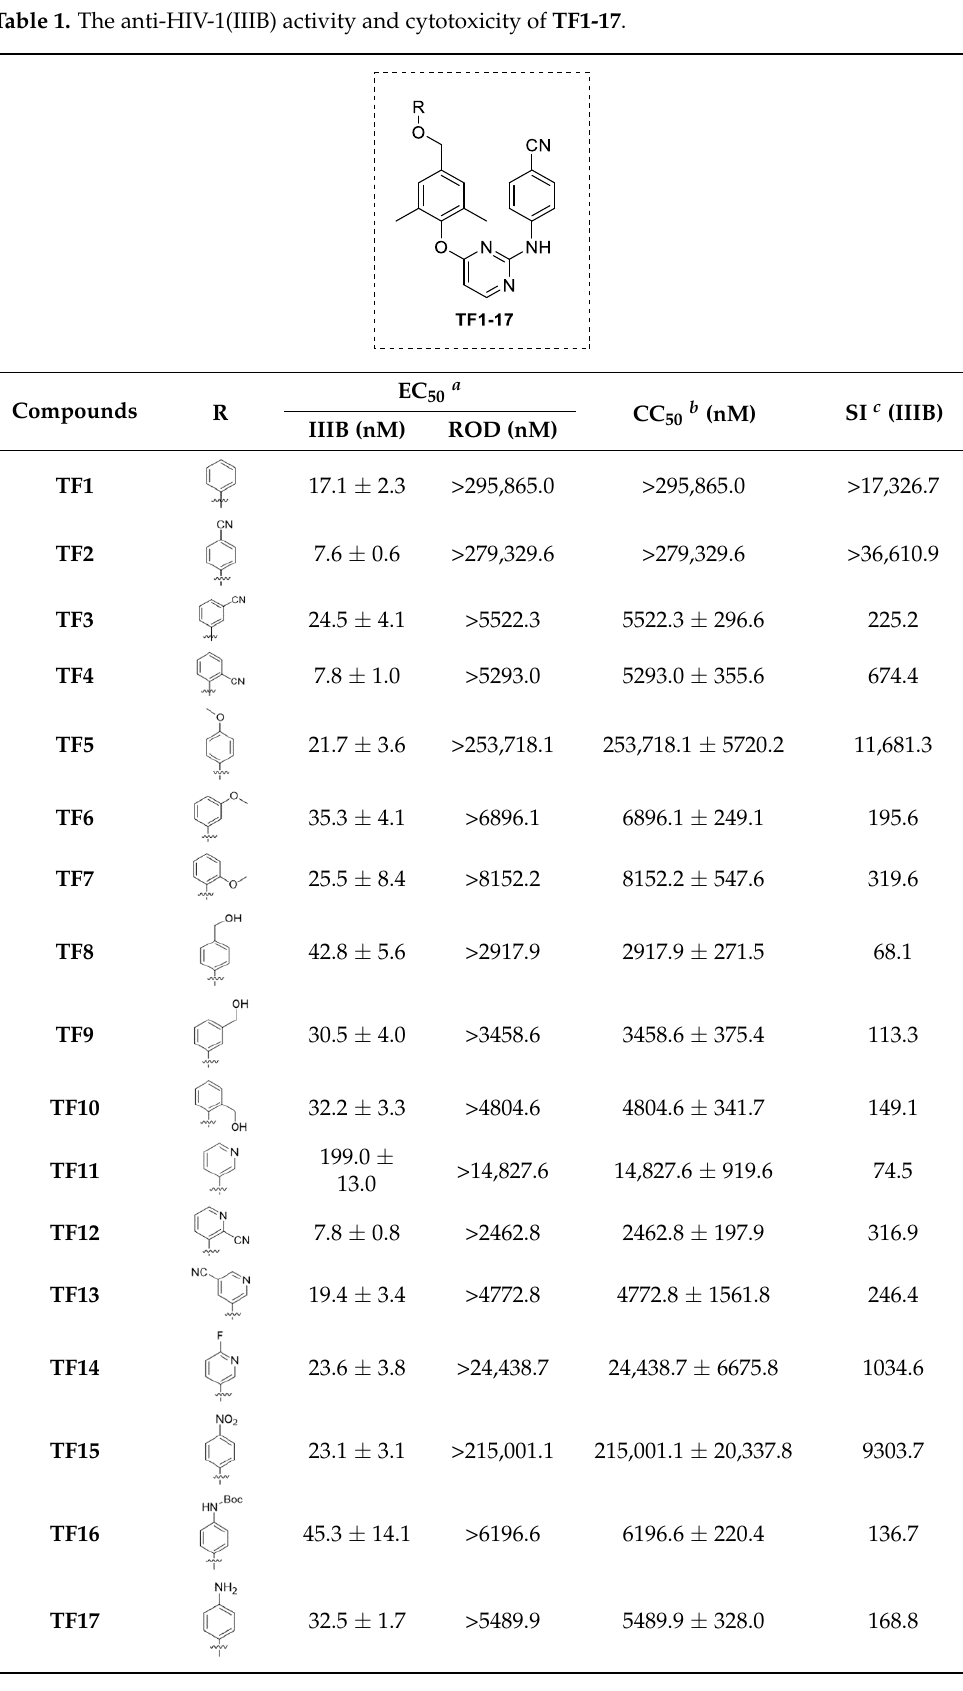
Table 1. The anti-HIV-1(IIIB) activity and cytotoxicity of TF1-17 .